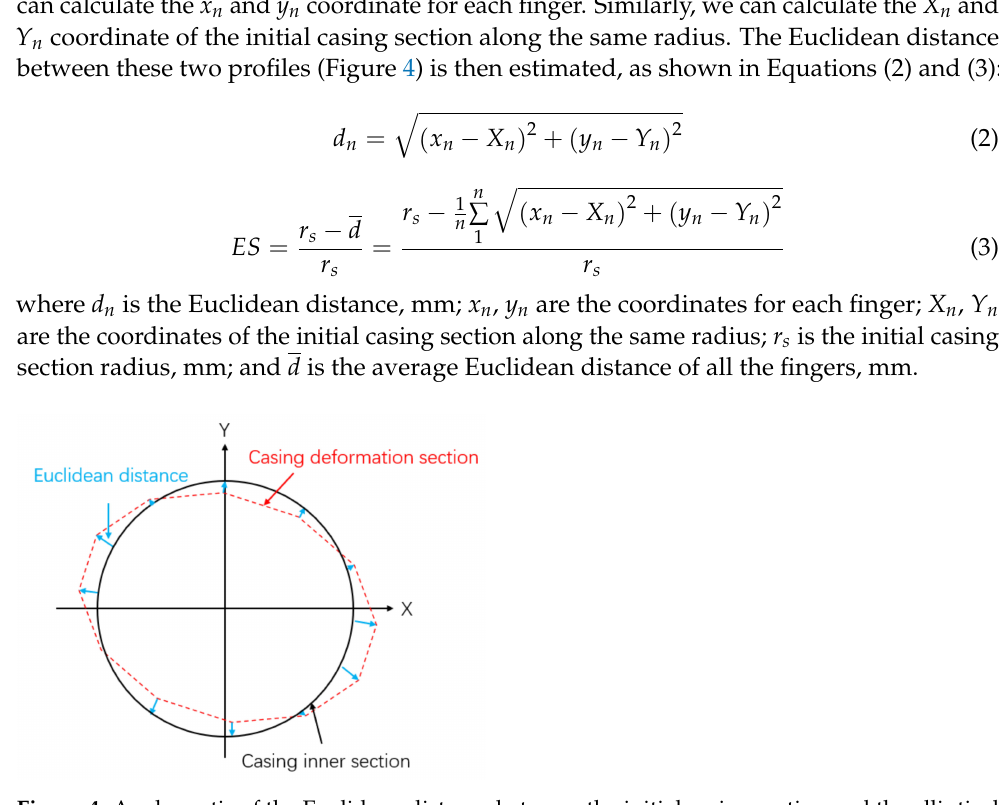
Figure 4. A schematic of the Euclidean distance between the initial casing section and the elliptical casing